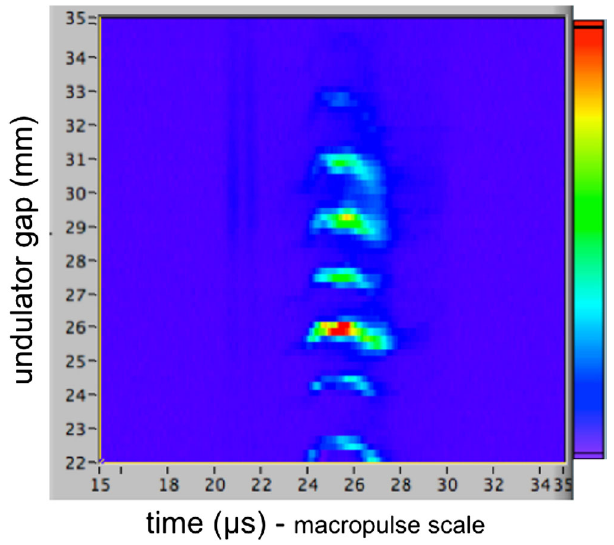
FIG. 6. Y cut of Fig. 5, showing the intensity of radiation vs centroid wavelength of the